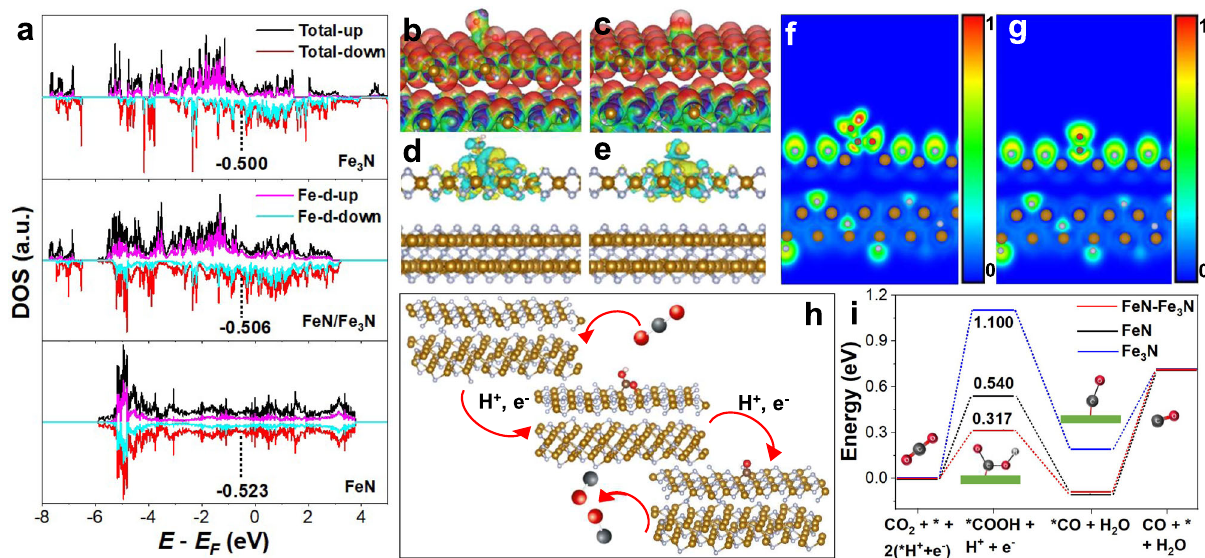
Fig. 5 | DFT calculations on the Fe − N catalyzed CO 2 RR. a The electronic density of states and d-band centers of Fe in the FeN, Fe 3 N, and FeN/Fe 3 N structures. The electrostatic potential for adsorption of COOH b and CO c on the FeN/Fe 3 N interface. 3D electron density difference distributions for adsorption of COOH